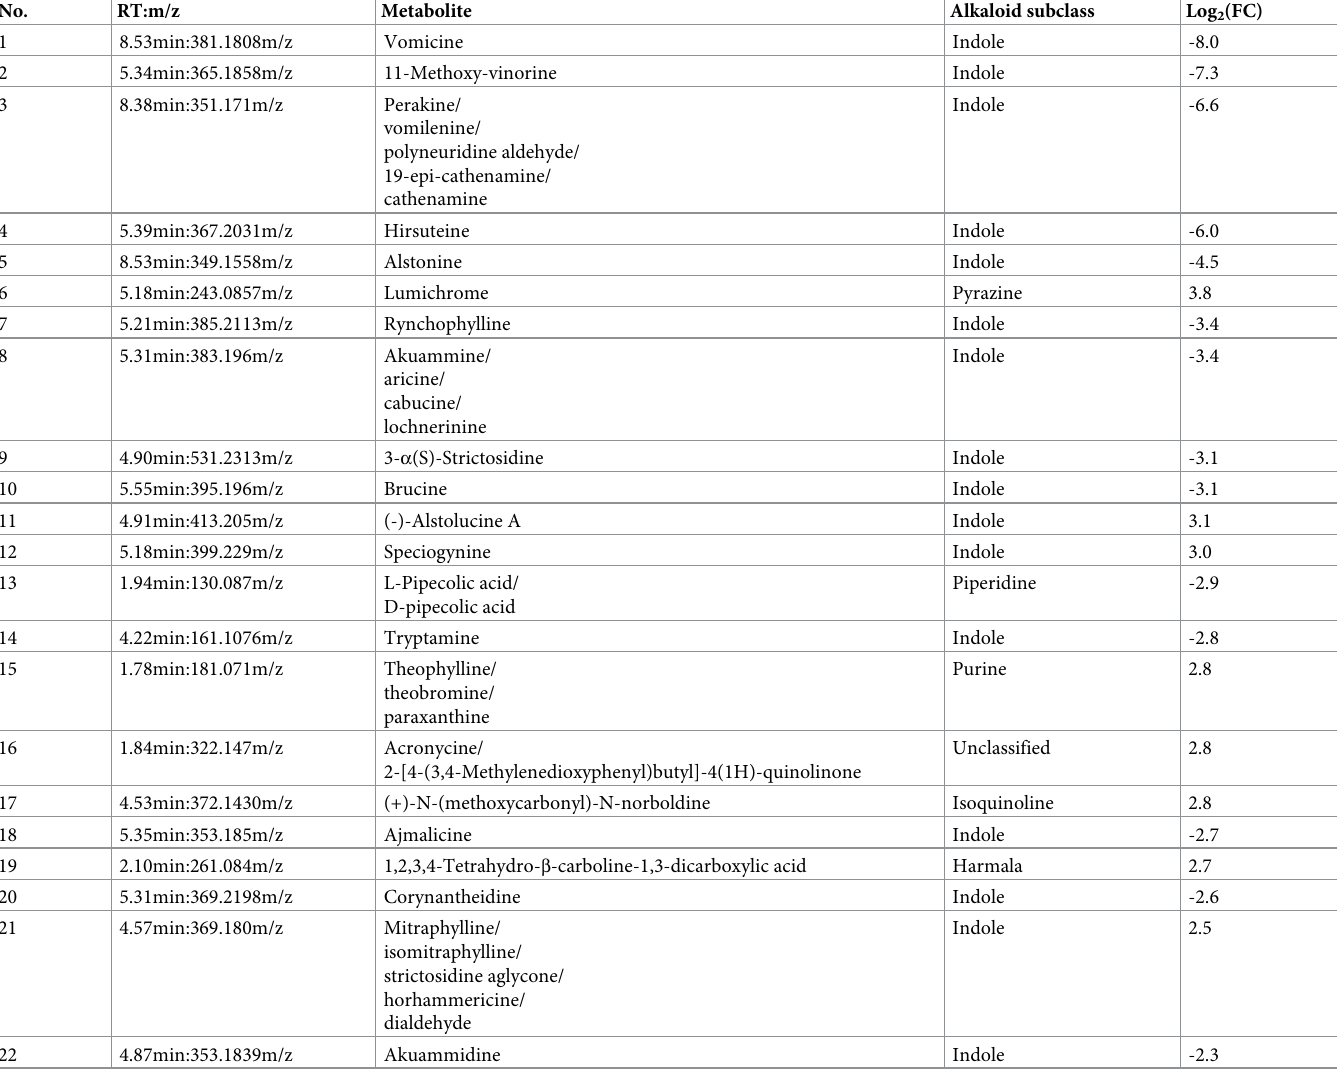
Alkaloids are deemed significant with a |Log 2 FC| >